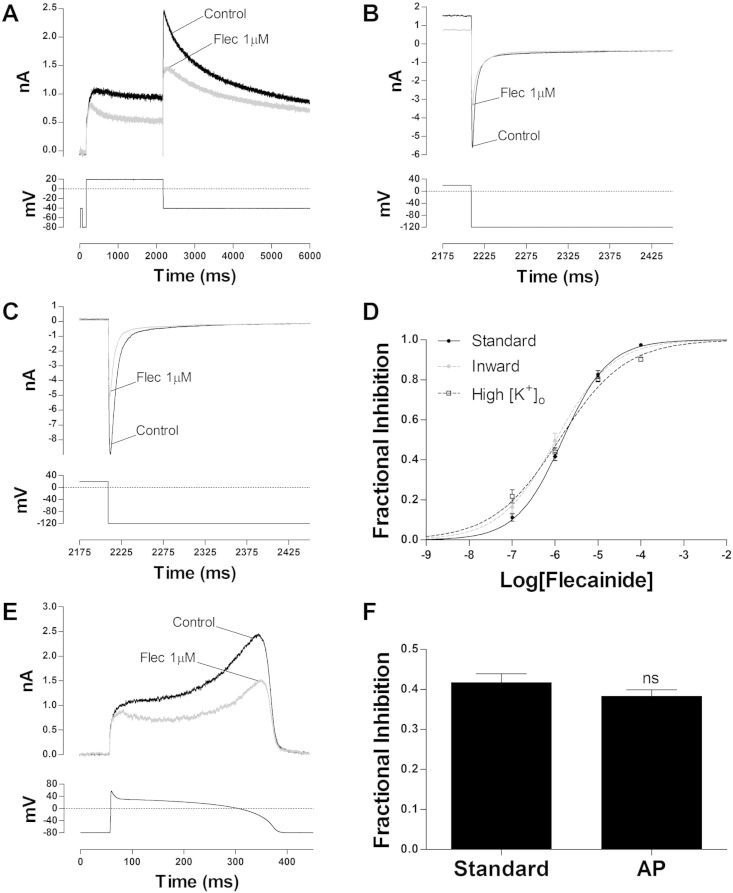
Effect of flecainide on WT IhERG.(A) Upper traces show WT IhERG elicited by a standard protocol (lower trace) before (black) and during (grey) exposure to 1 μM flecainide.(B) Inward WT IhERG (upper traces) measured at − 120 mV following an activating command to + 20 mV, before (black) and during (grey) exposure to 1 μM flecainide. The current traces are displayed to focus on the portion corresponding to repolarization from + 20 to − 120 mV.(C) Inward WT IhERG measured at − 120 mV following an activating command to + 20 mV in high [K+]o (94 mM) before (black) and during (grey) exposure to 1 μM flecainide.(D) Concentration–response relations for flecainide inhibition of WT IhERG elicited under the different experimental conditions in A, B and C (n ≥ 5 at each concentration). IC50 and nH values are given in the Results text.(E) Upper traces show WT IhERG elicited by an AP voltage command before (black) and during (grey) exposure to 1 μM flecainide. (F) Comparison between the effect of 1 μM flecainide on WT IhERG elicited by the standard protocol shown in ‘A’ (n = 21) and the AP voltage command (n = 6) (ns, p > 0.05 unpaired t-test vs. Standard).